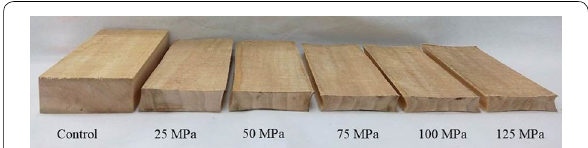
Table 1 Average compress ratios and density of wood samples after various HP densification for 30 s Pressure (MPa) Original Thickness